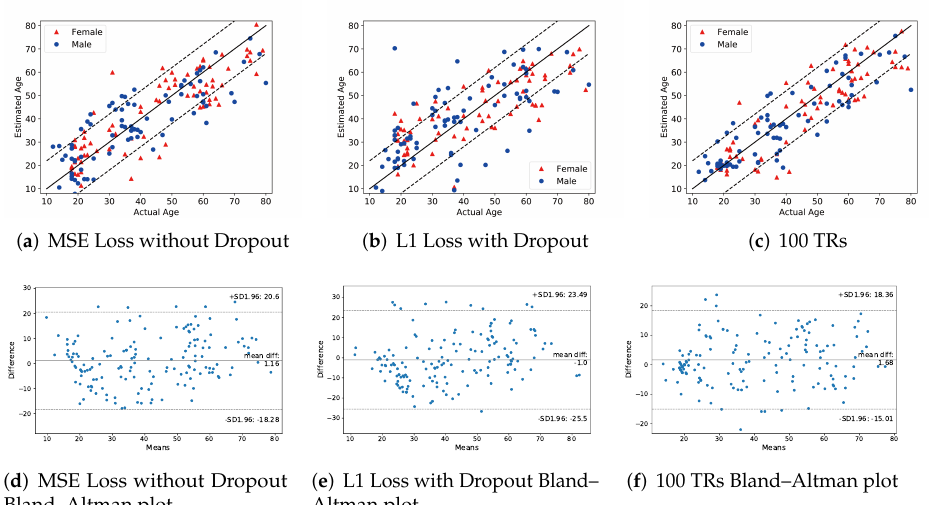
Figure 5. Ablation Study. The x -axis represents the actual age of the subject, whereas the y -axis represents the estimated age. ( a ) MSE loss function without dropout; ( b ) (cid:96) 1 loss function with dropout; ( c ) first 100 repetition time points only (with MSE loss function and dropout). The solid line is the best diagonal when the actual age matches the estimated age. The dotted line refers to the deviation line 12 years away from the actual age. The second line of figures are the Bland–Altman (B&A) plot corresponding to the above. ( d ) MSE without dropout (B&A plot); ( e ) (cid:96) 1 with dropout (B&A plot); ( f ) 100 TRs (B&A plot). The x -axis is the average of each sample’s actual and predicted age, and the y -axis is the difference between the exact age and the predicted age of the sample. The solid line is the average of the difference. The dashed line is the upper and lower limits of 95% agreement, i.e., ± 1.96 standard